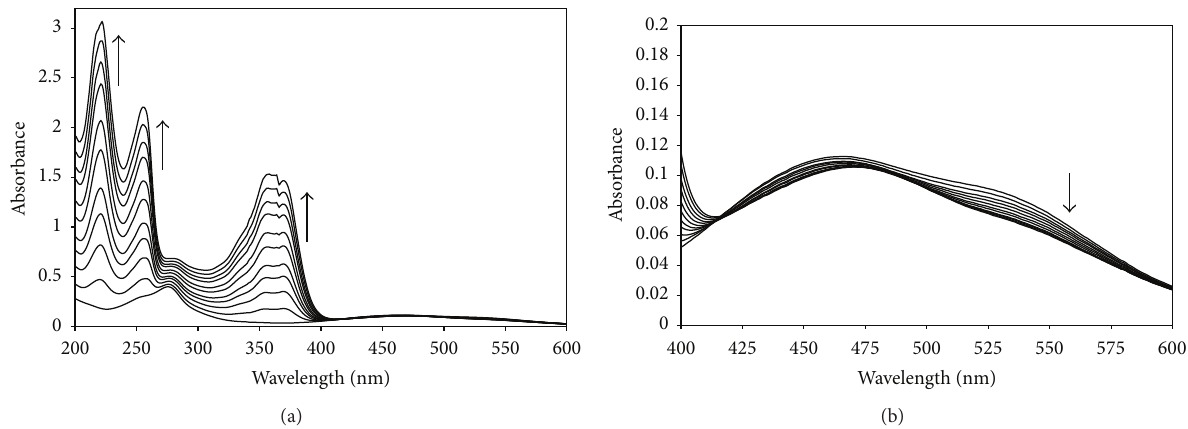
F 6: Absorption spectra of the competitive interaction between CPT-11 and NR bonded to ds-DNA in the wavelength ranges of (a) 220–600nm and (b) 400–600nm. Conditions: for curves